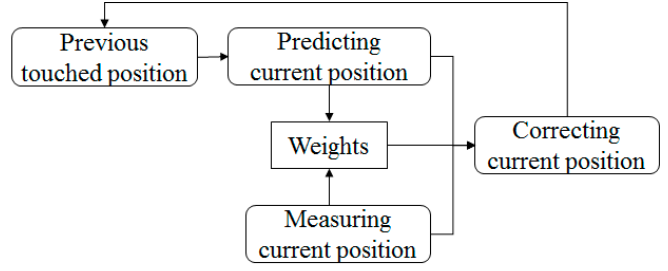
Figure 11. Flowchart of proposed filtering.